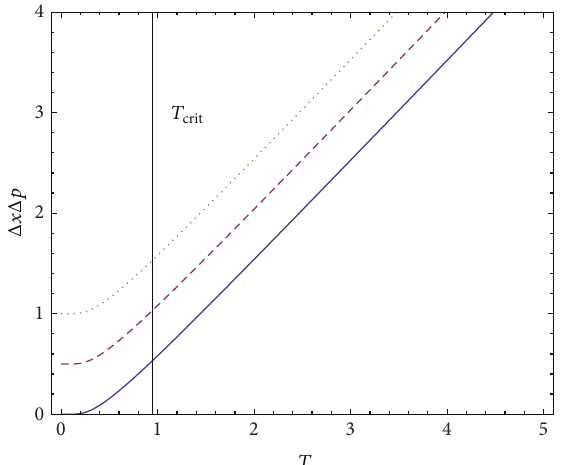
Figure 5: Fluctuations versus the temperature 𝑇 in (ℏ𝜔/𝑘 𝐵 ) -units. The solid line is the case 𝑃 , the dashed one is the Wigner one, and the dotted line is assigned to the Husimi instance.